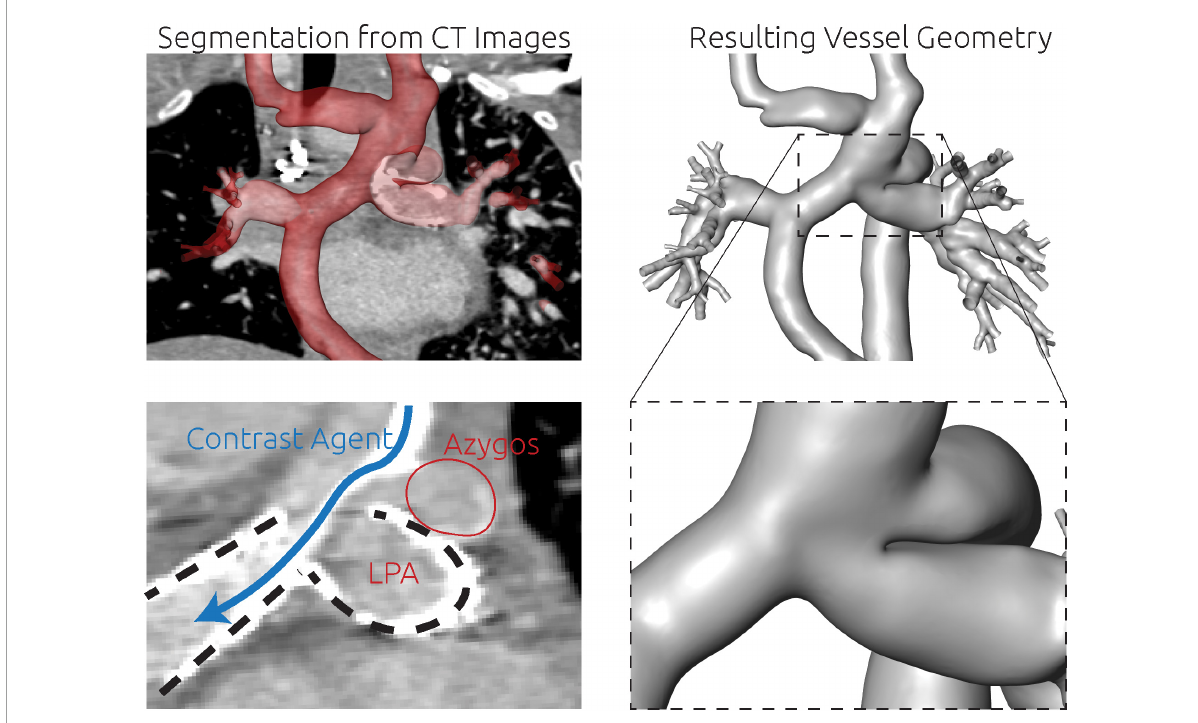
FIGURE8 Detailed overview of the segmentation strategy for the third patient. The whole anatomy was reconstructed from CT images (top row). There were two metallic stents in the LPA and RPA (bottom left, dashed lines). Furthermore, the contrast agent deriving from the SVC was unevenly distributed and visible as a high contrasted band flowing toward the RPA (blue arrow). Directly superior to this complex region, also the azygos vein connected to the SVC. The separation between LPA and azygos vein could only be discriminated by the location and orientation of the LPA